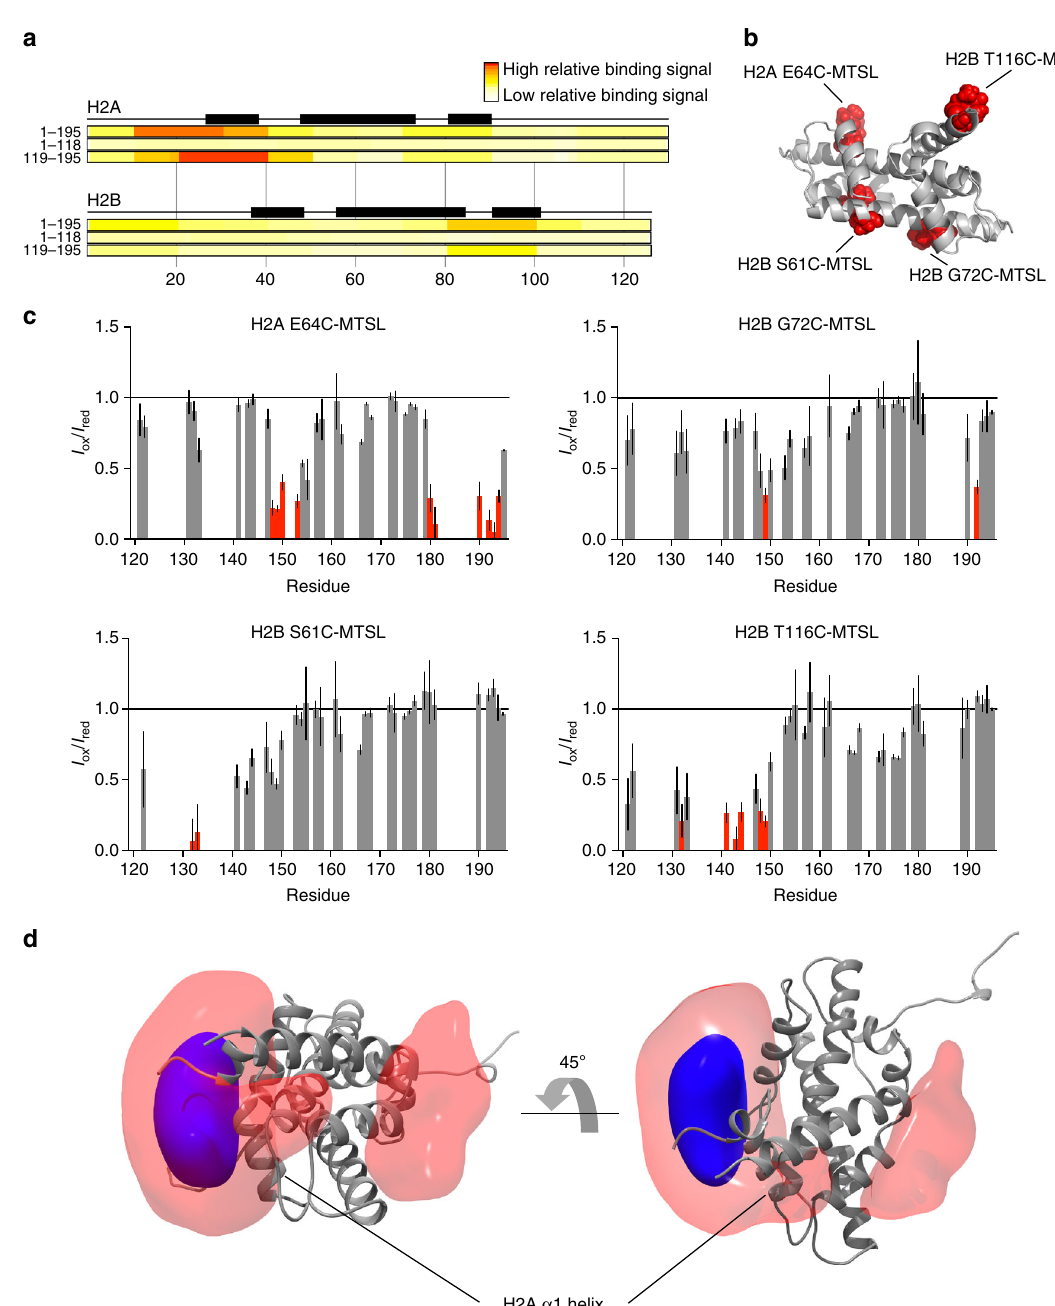
Fig. 5 Mechanisms of H2A/H2B binding by the Npm tail domain. a Histone peptide array result using three different Npm truncations probed against comprehensive H2A/H2B peptides on a chip. Top = full-length Npm (1 – 195), middle = Npm core (1 – 118), bottom = GST-tagged Npm tail (119 – 195). Black boxes represent positions of α -helices in the histone fold. b Positions of MTSL paramagnetic spin labels on the H2A/H2B dimer structure. Histone tails removed for clarity. c I ox / I red graphs of the Npm tail domain bound to H2A/H2B at 400 µ M concentration. Four sets of intermolecular PRE effects derived from the complex. Error bars are inversely proportional to the propagated signal-to-noise ratio of individual resonances. Same coloring scheme as used in Fig. 3a. d Reweighted atomic probability density maps indicating the most likely positions of A2 around the H2A/H2B dimer (gray ribbon, histone tails removed for clarity). Transparent red contoured at 10%, and solid blue contoured at 50%. Two distinct binding sites are consistent with the PRE